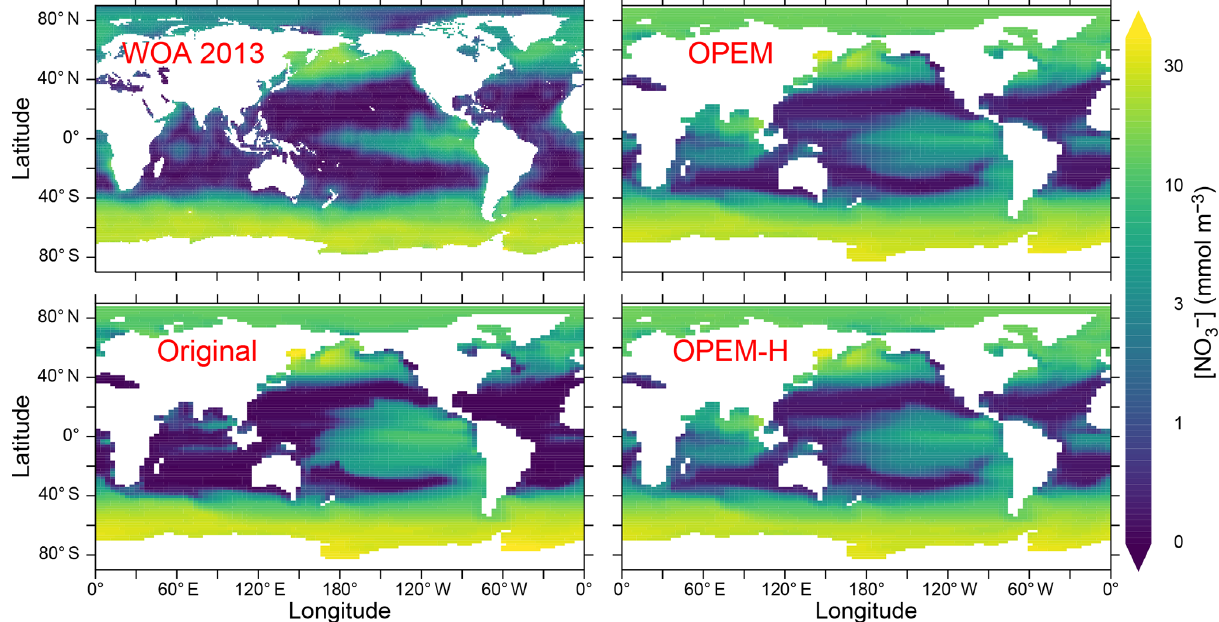
Figure 4. Annually averaged distribution of NO − and OPEM-H UVic